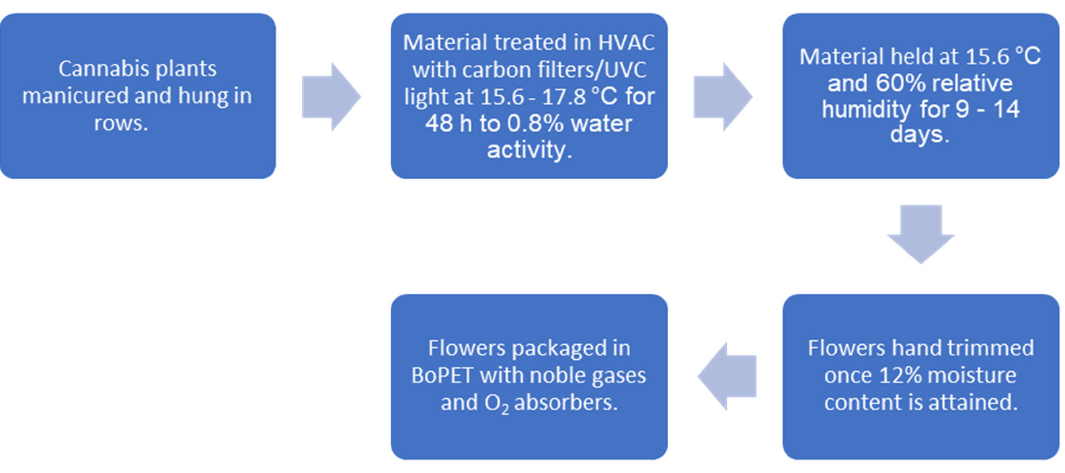
Figure 11. Cannabis drying and packaging schematic. Figure 10. Cannabis drying and packaging